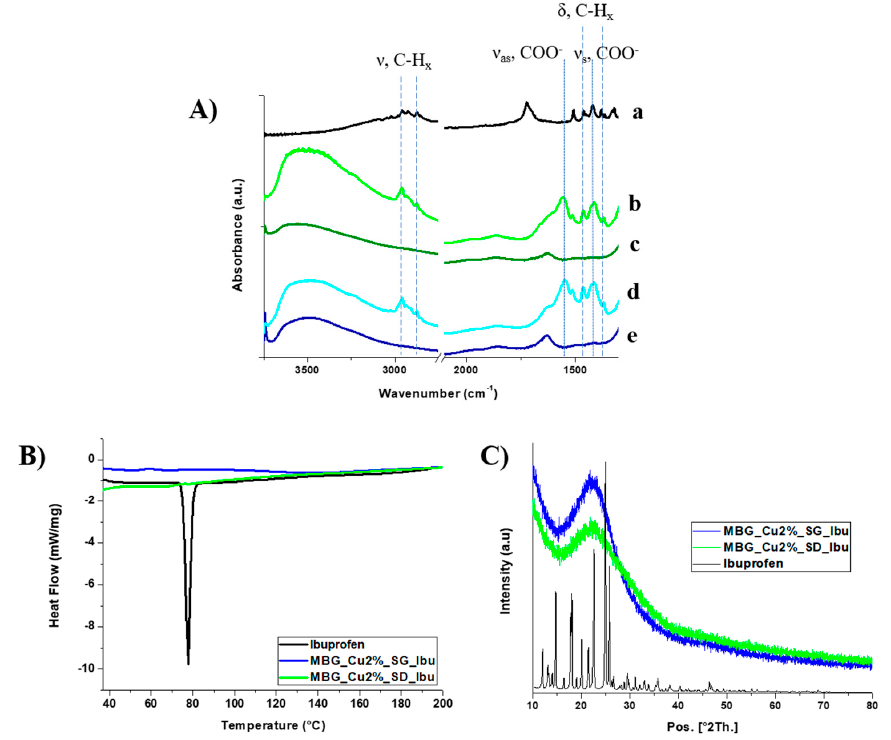
Figure 3. ( A ) Fourier transformed infrared (FTIR) spectra of ibuprofen ( a ), MBG_Cu 2%_SG_Ibu ( b ), MBG_Cu2%_SG ( c ), MBG_Cu 2%_SD_Ibu ( d ) and MBG_Cu2%_SD ( e